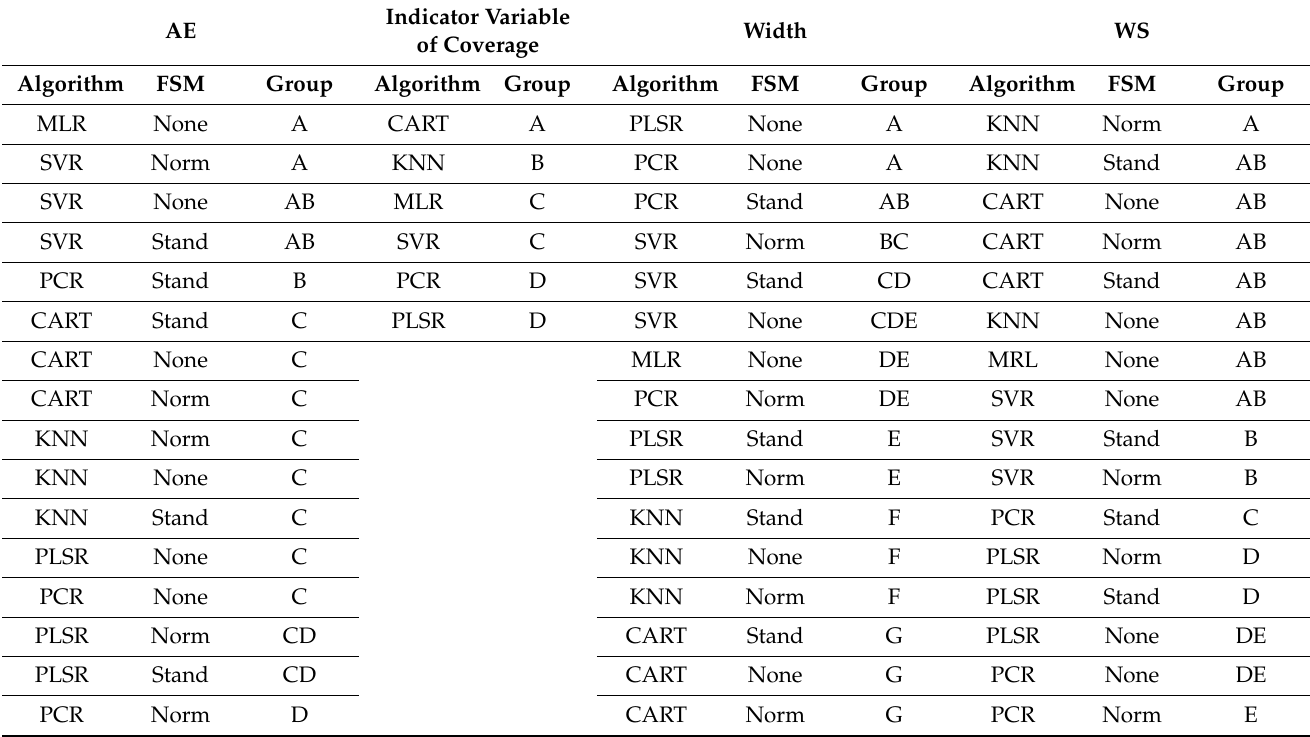
Table 7. Homogenous groups of models after post-hoc